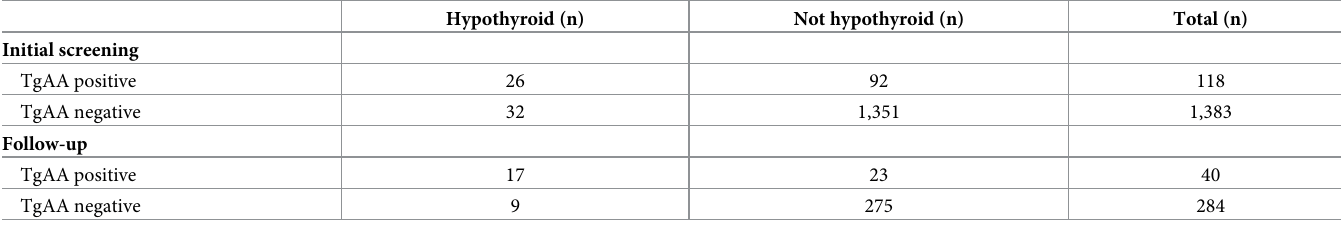
Table 4. Cross table for sensitivity, specificity, positive predictive value and negative predictive value of TgAA status at the initial screening and follow-up examination. Hypothyroid (n) Not hypothyroid (n) Total